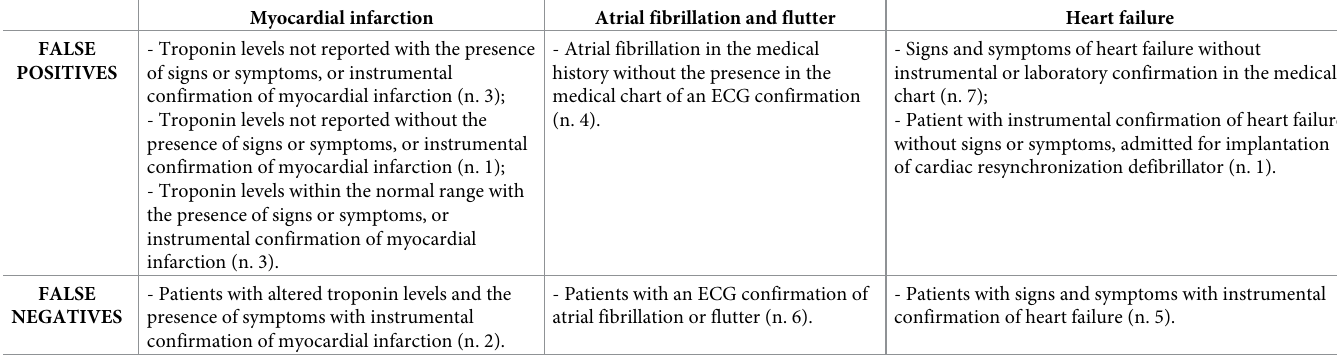
Table 5. Reasons for incorrect identification of cases and